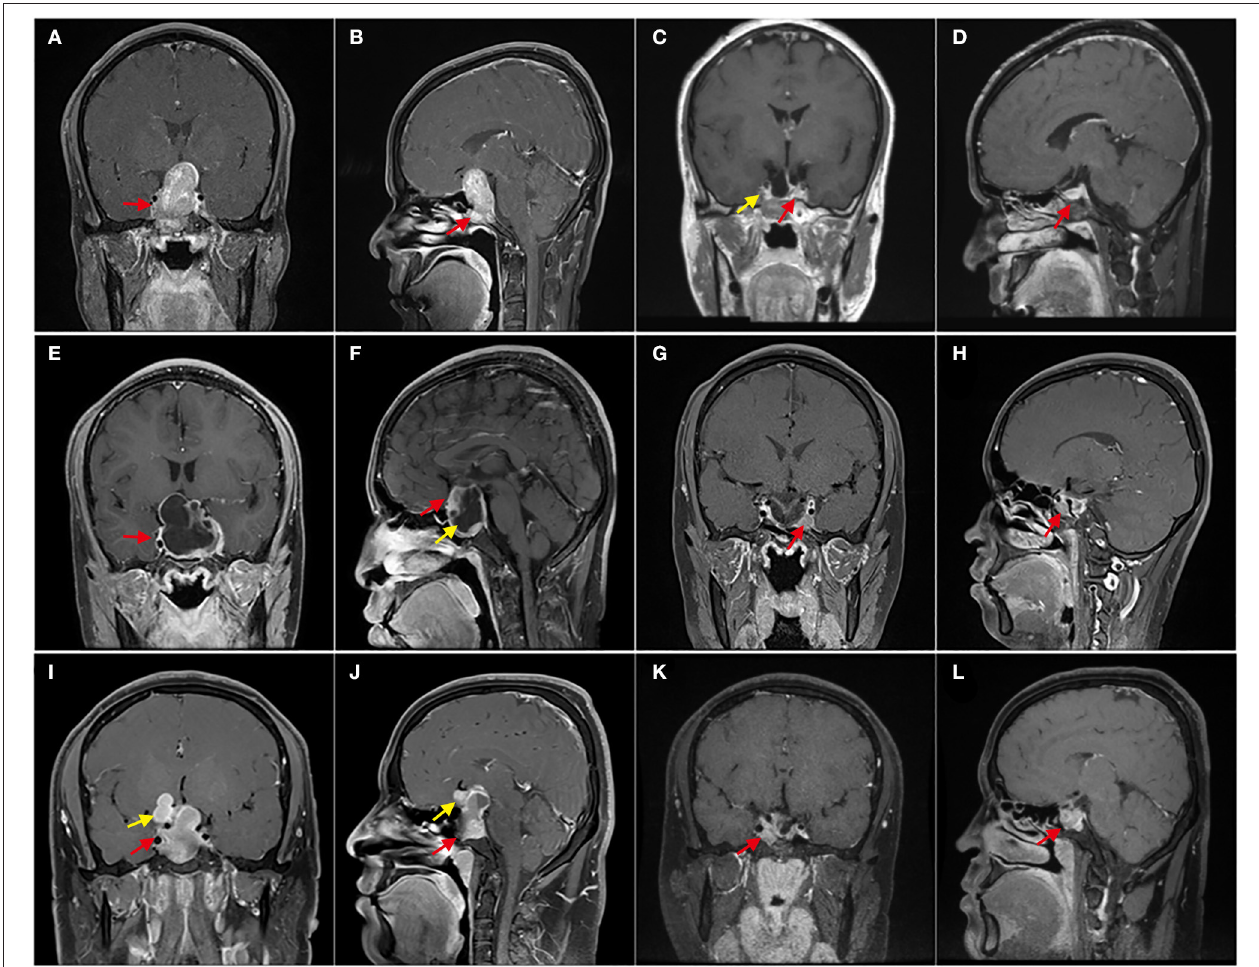
FIGURE 1 | Enhanced T1 MRI with different resection degrees. (A–D) Patient 1, Preoperative MRI showed that the tumor invaded the sphenoid sinus downward and severely squeezed the right cavernous sinus (red arrow); 3 months after the operation, MRI showed that there was no residue in the right cavernous sinus (yellow arrow), and the normal pituitary was located on the left side of the sellar area (red arrow); It is gross-total resection. (E–H) Patient 2, E shows GPA with giant cystic, and F shows solid components (red arrow) and cystic components (yellow arrow); (G,H) , 3 months after the operation, MRI shows a few residual tumors in the left cavernous sinus (red arrow). With a residual of about 5%, which was subtotal resection. (I–L) Patient 3, the tumor was lobulated, extended to the anterior and suprasellar (yellow arrow), and invaded the sphenoid sinus (red arrow); (K,L) shows that 3 months after the operation, the residual tumor was mainly located in the left cavernous sinus (red arrow), and the residual was about 25%, which was partially